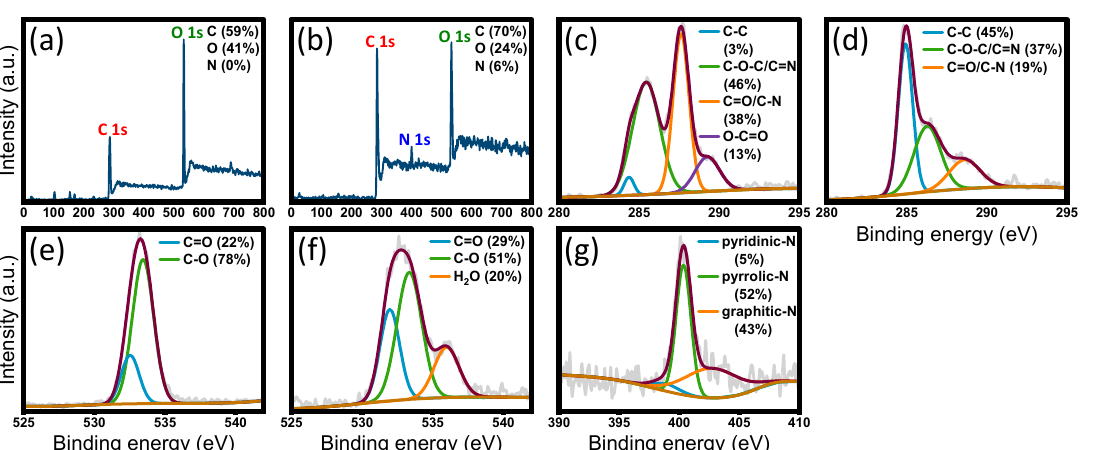
related to the bacteriostatic properties of GO/rGO [33].